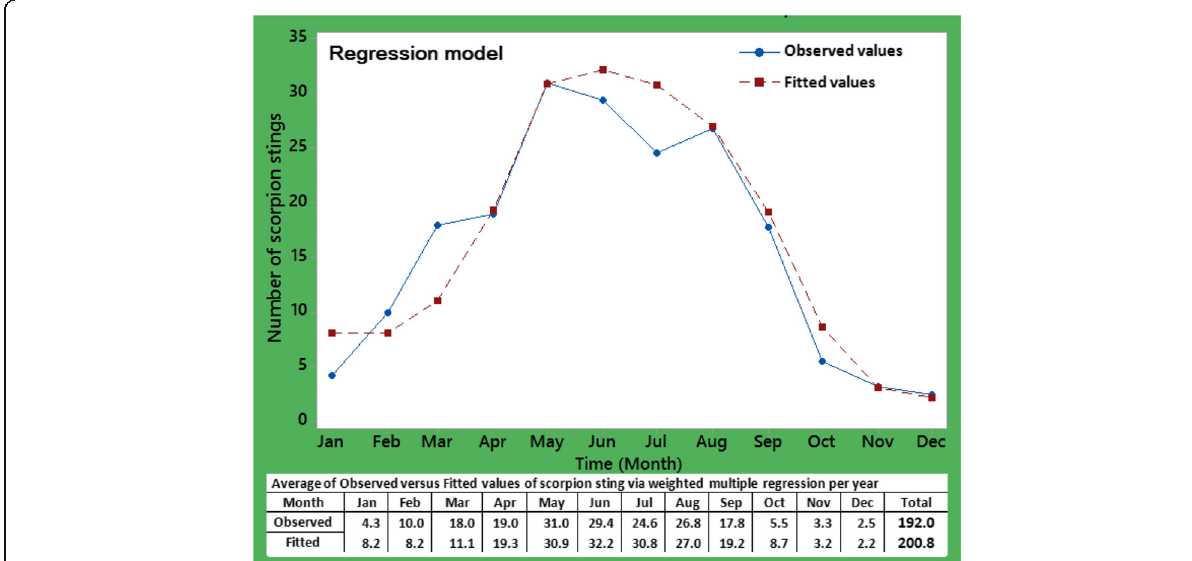
Fig. 4 Plot of average of the observed and fitted values for scorpion sting cases between the years 2012 and 2016 using weighted regression